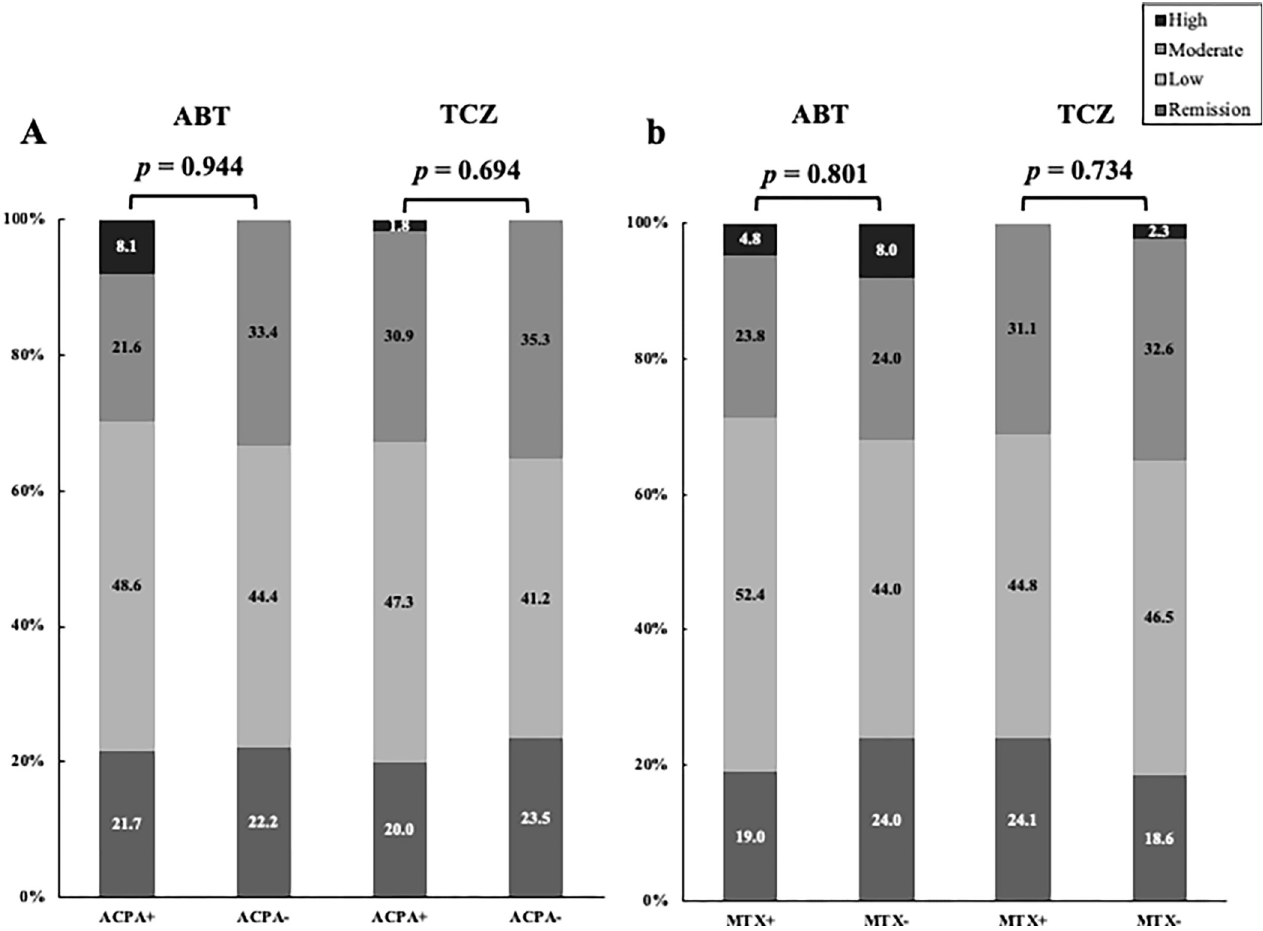
Fig 3. Proportions of patients who archived LDA or remission based on CDAI between elderly patients initiating with ABT or TCZ at 24 weeks according to the presence of ACPA or the concomitant use of MTX. Disease activity was classified into four categories as HDA, MDA, LDA, remission based on CDAI. (A) There was no significant difference in the portions of archiving LDA or remission between elderly patients initiating with ABT or TCZ according to the presence of ACPA. (B) There was no significant difference in the portions of archiving LDA or remission between elderly patients initiating with ABT or TCZ according to the use of